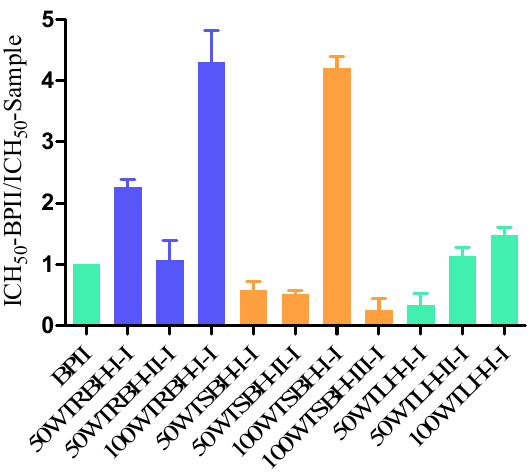
Figure 2. Complement-fixating activities of purified polysaccharide fractions obtained from root bark, stem bark and leaves of T. macroptera related to positive control